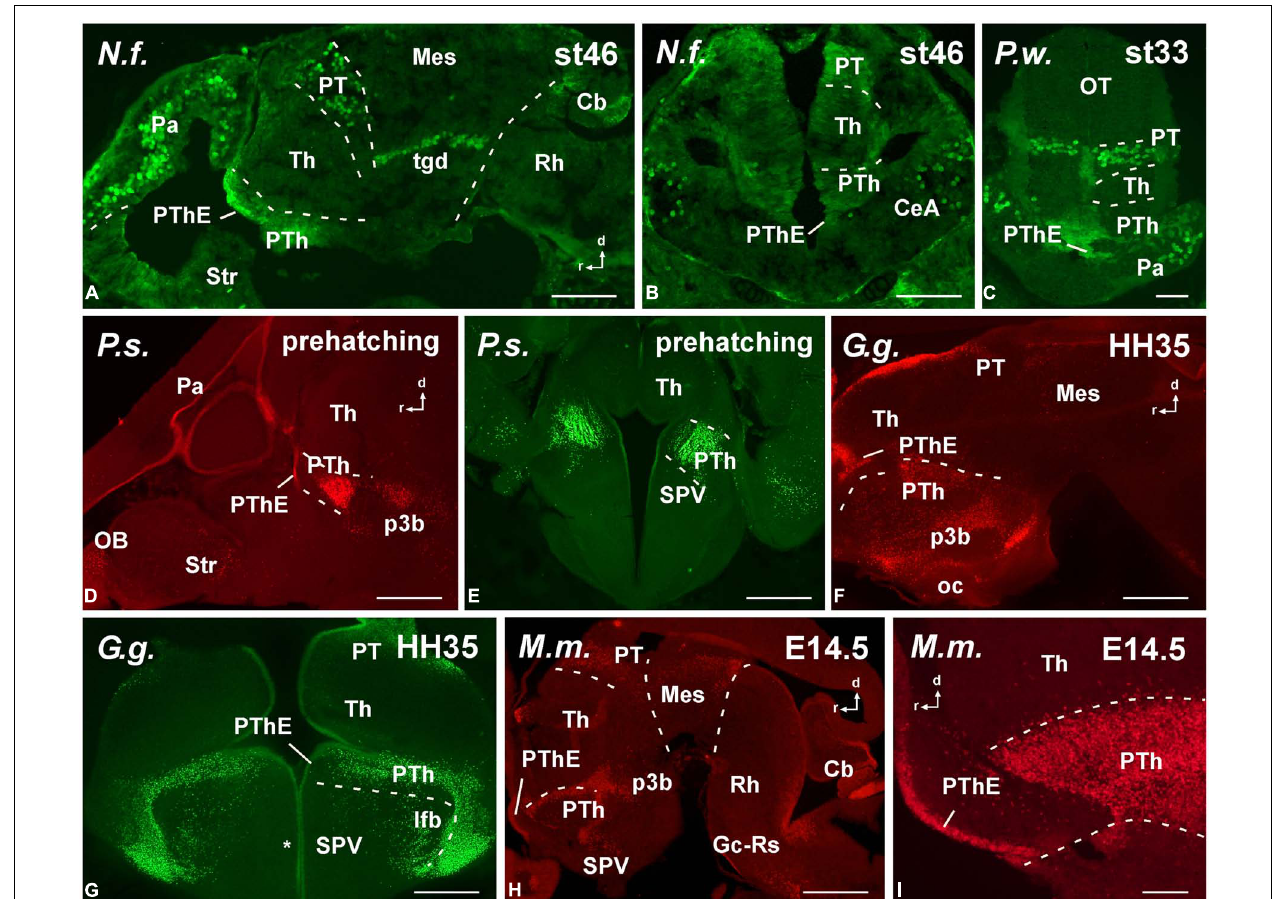
FIGURE 4 | Photomicrographs of sagittal (A,D,F,H,I) and transverse (B,C,E,G) sections at diencephalic levels that illustrate the localization of Pax6-immunoreactive cells in the ventricular zone of the prethalamic eminence in anamniotes (A–C) and amniotes (D–I) and the subventricular and mantle zone found in the